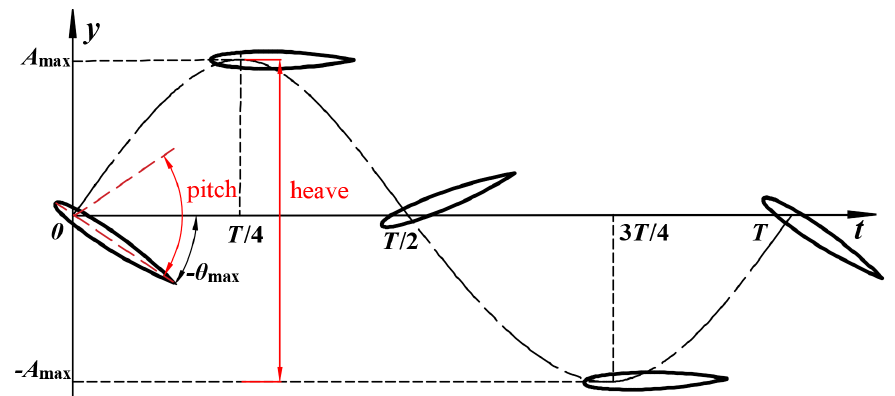
Figure 1. Schematic diagram of hydrofoil.